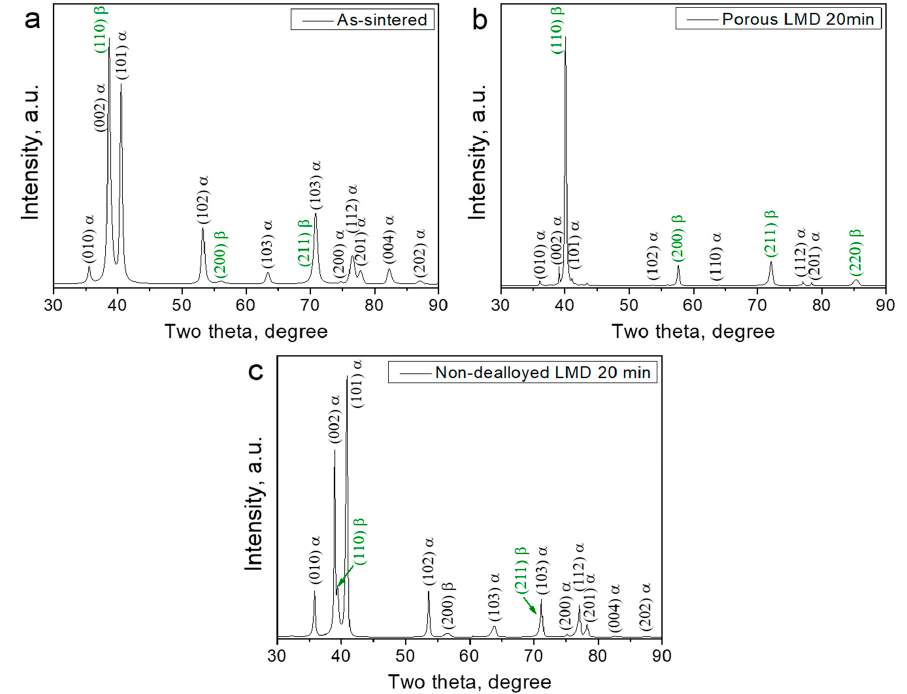
Figure 1. X-ray diffractograms of the as-sintered and dealloyed commercial Ti-6Al-7Nb alloy. ( a ) As-sintered; ( b ) Porous dealloyed layer of the Ti-6Al-7Nb alloy dealloyed for 20 min; ( c ) Non-dealloyed region of the Ti-6Al-7Nb alloy subjected to liquid metal dealloying for 20 min. Nanomaterials 2020 , 10 , x; doi: FOR PEER REVIEW